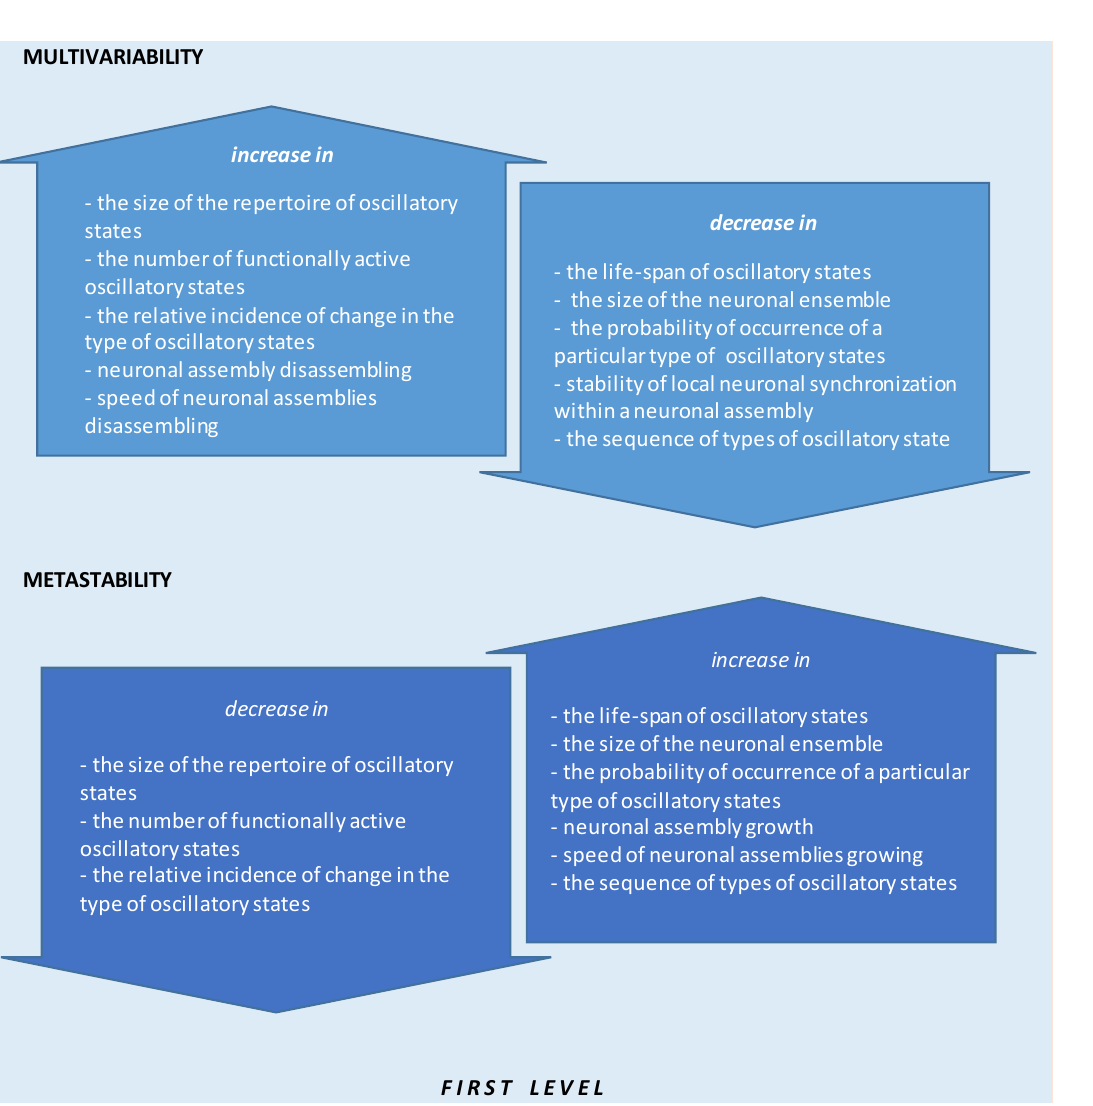
Figure 1. The first level of multivariability and metastability measured by qEEG. Different cortex regions have different dominant qEEG oscillations [150,428] that act as resonant communication networks through large populations of neurons [140,429].